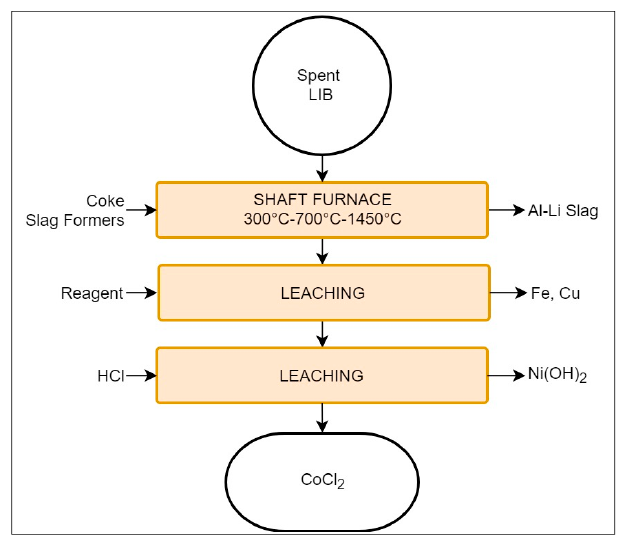
Figure 6. Schematic representation of the Umicore Valéas recycling process.